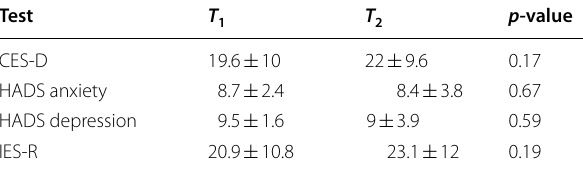
Table 2 Results regarding psychological tests for depression, anxiety, and post-traumatic stress disorder between video-calls in the overall cohort of caregivers. Four psychological tests were